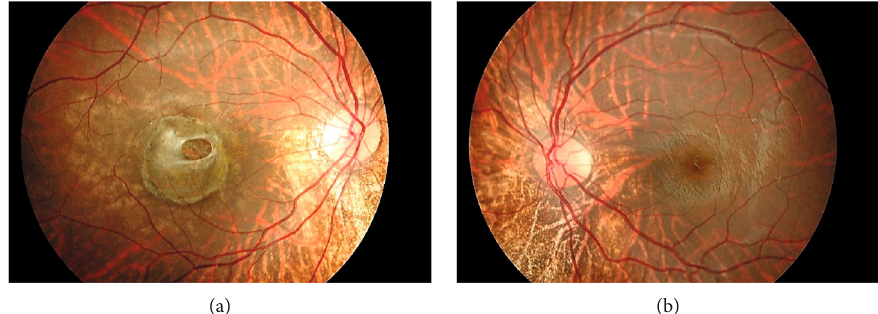
Figure 3: Fundus photographs of the right (a) and left (b) eyes. Note the di ff use choroidal hypopigmentation with increased visibility of the choroidal blood vessels. A full-thickness macular hole with underlying choroidal excavation observed in the right